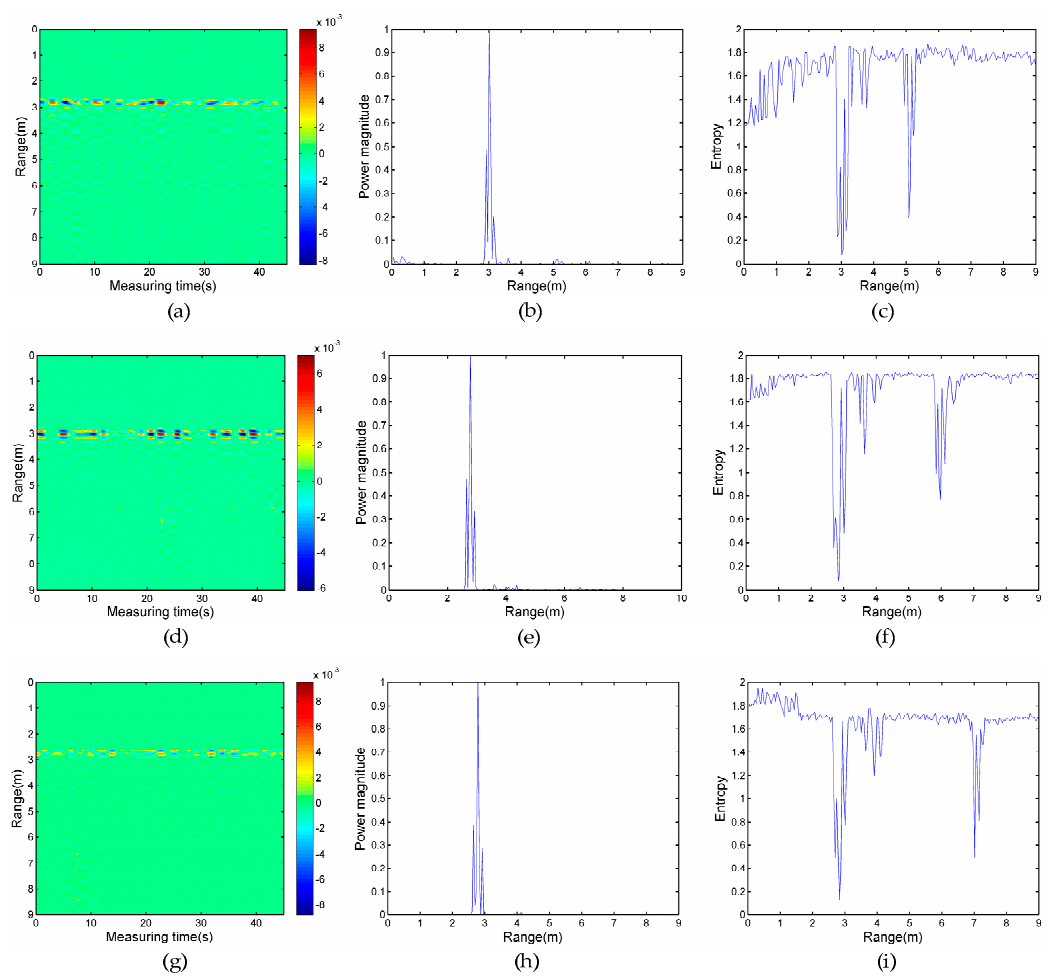
Figure 9. ( a ) The data of experiment I processed by an adaptive filter; ( b ) the power spectrum of the data of experiment I; ( c ) the entropy spectrum of the data of experiment I; ( d ) the data of experiment II processed by an adaptive filter; ( e ) the power spectrum of the data of experiment II; ( f ) the entropy spectrum of the data of experiment II; ( g ) the data of experiment III processed by an adaptive filter; ( h ) the power spectrum of the data of experiment III; and ( i ) the entropy spectrum of the data of experiment III.